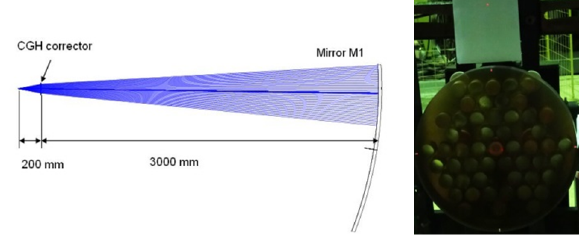
Fig 1 . Testing scheme and focusing alignment elements of off-